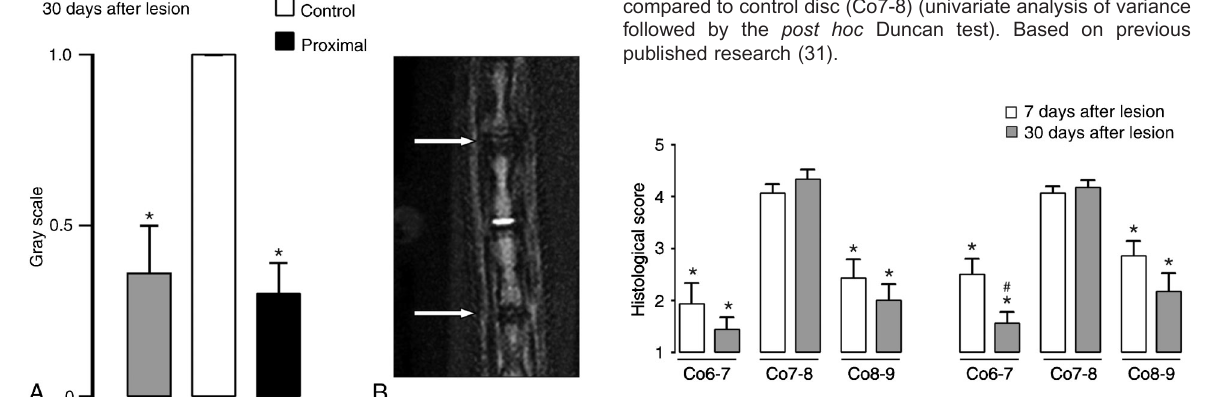
Figure 4. Histological analysis of the nucleus pulposus (left) and annulus fibrosus (right) 7 and 30 days after lesion. Punctured proximal and distal discs showed a significant decrease of histological score compared to control (Co7-8). There was no difference between proximal and distal discs. The Cohen kappa coefficient showed a significant degree of histological interobser- ver agreement. *P , 0.05 compared to control; # P , 0.05 compared to 7 days (univariate analysis of variance followed by the post hoc Duncan